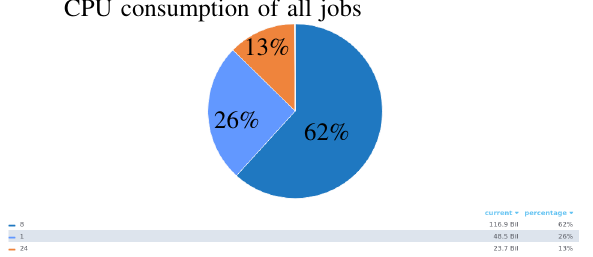
Figure 7. CPU consumption of jobs running under praguelcg2. The orange color represents contri- bution of the Salomon. It opportunistically provided 13% of CPU time which praguelcg2 delivered to ATLAS.